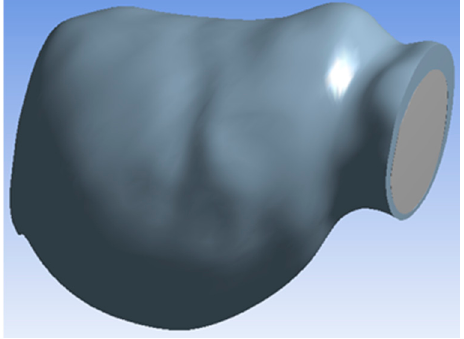
Figure 2. Aneurysm geometry.